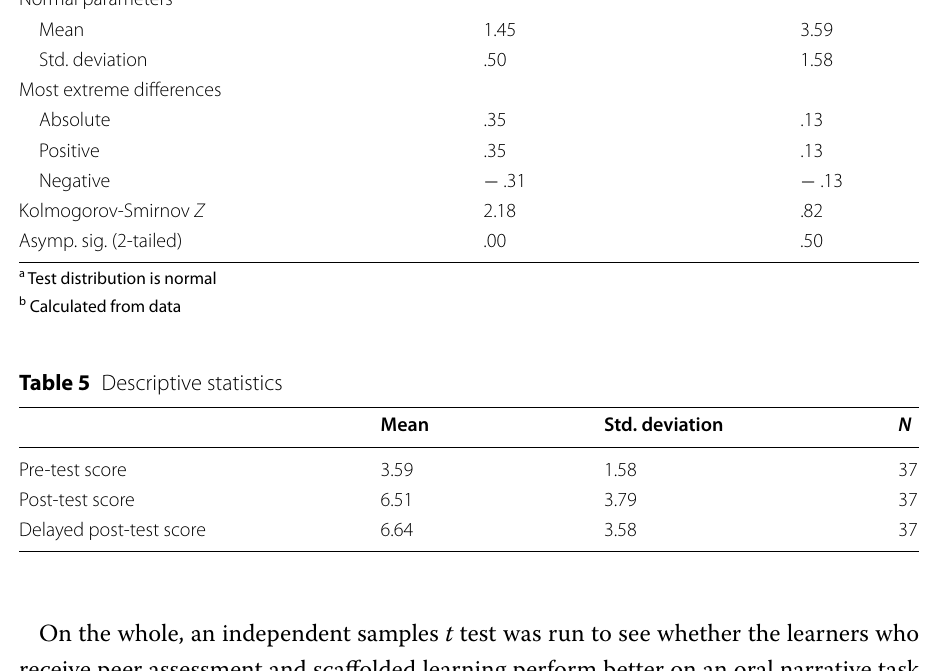
Table 4 One-sample Kolmogorov-Smirnov test